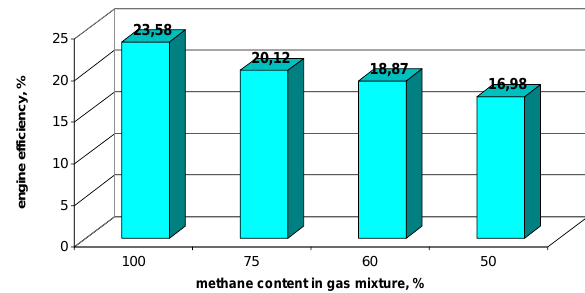
Fig. 14. Impact of throttle position on engine overall